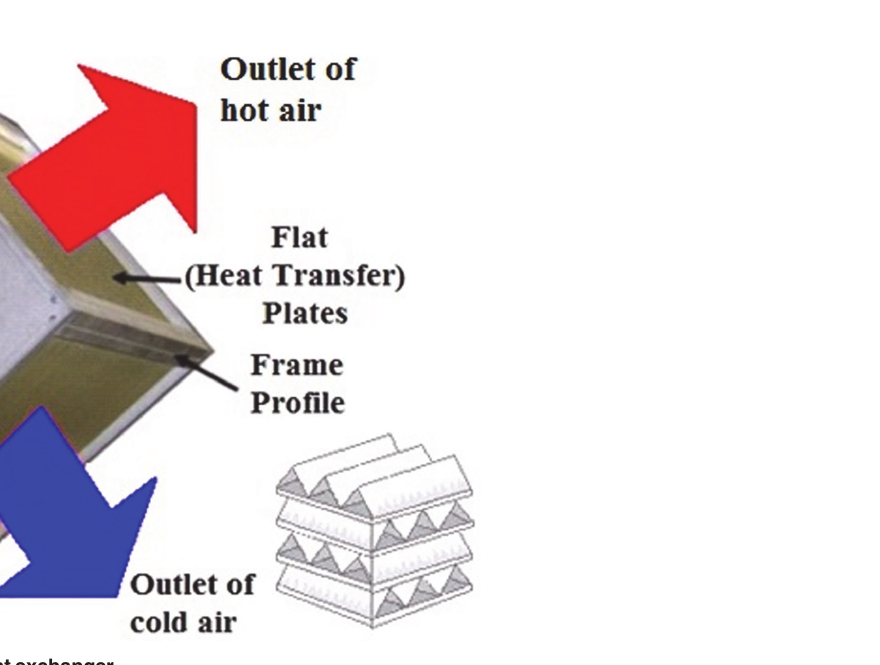
Fig 2. Structure of air-to-air cross flow plate fin heat